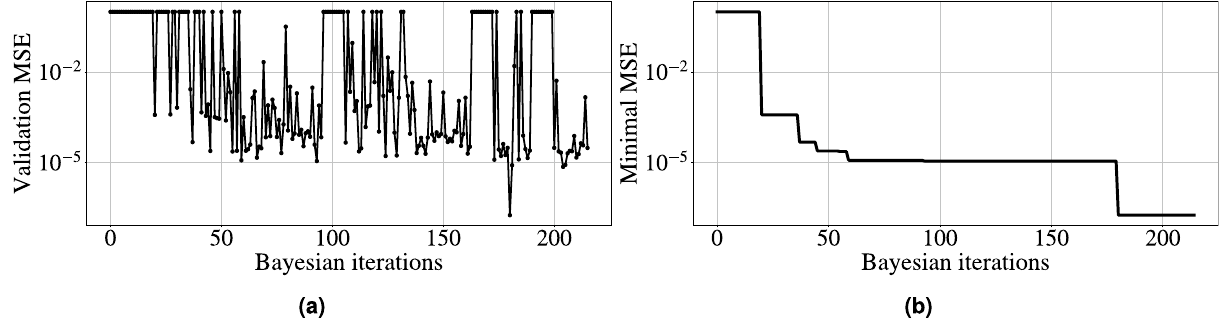
Figure 2. (a) The dependence of the mean squared error (MSE) value on the number of Bayesian iteration. (b) The same for minimal value of